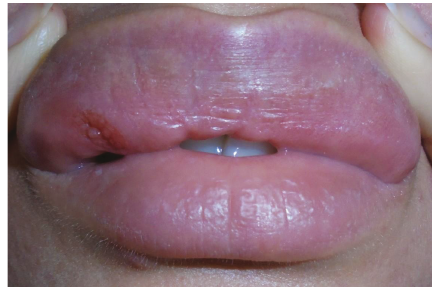
Figure 2: Anterior view of patient showing ulcerated region and puncture wound.